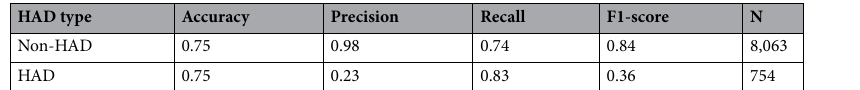
Table 9. Prediction performance of HAD binary classification in OPD data set.